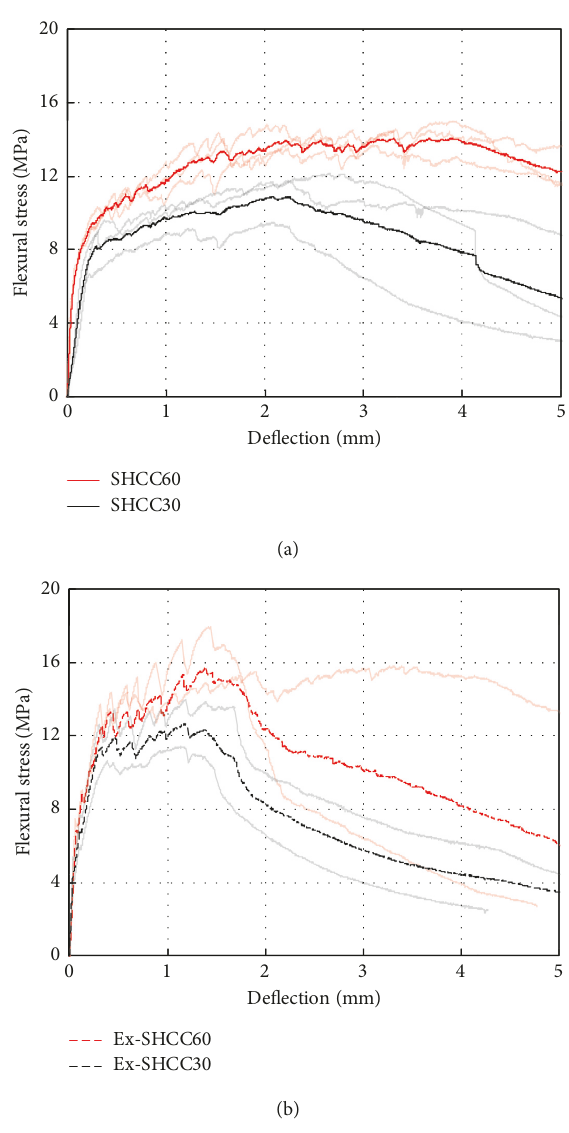
Figure 6: Effects of expansive admixture on flexural responses of SHCC and Ex-SHCC mixtures. (a) SHCC mixtures. (b) Ex-SHCC mixtures. Table 5: Tensile and flexural properties of SHCC and Ex-SHCC